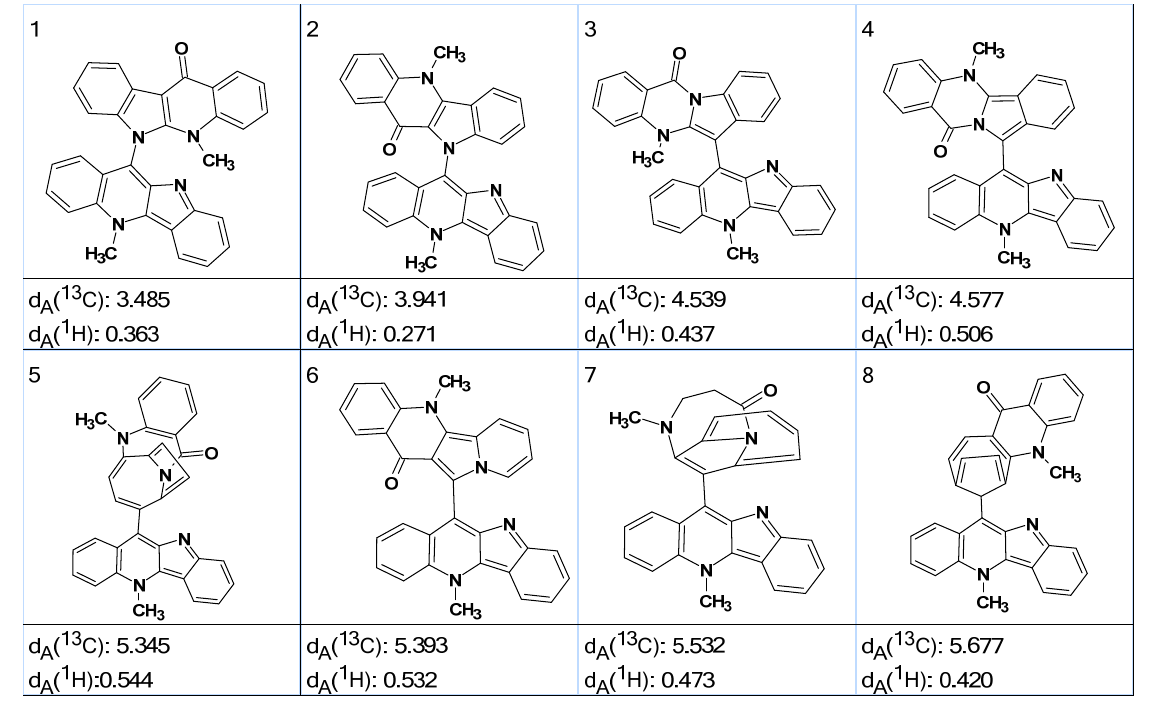
Figure 7. Eight top ranked structures of the output file.